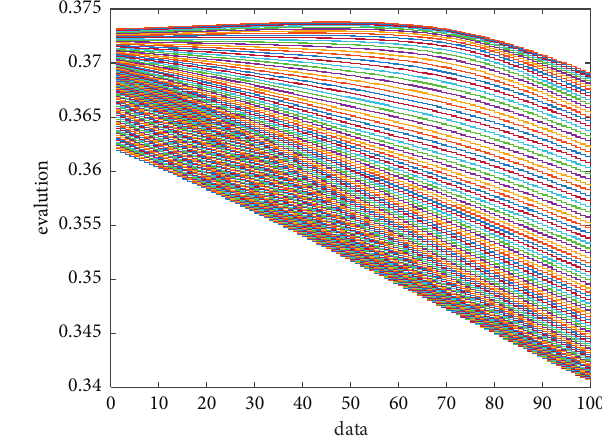
Figure 7: Evaluation.